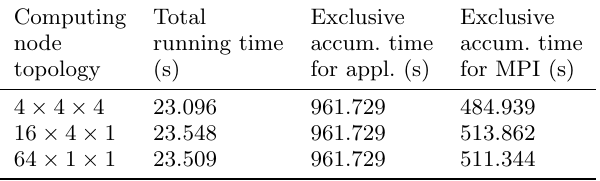
Table 1: Simulation results for three topologies Computing Total Exclusive Exclusive node running time accum. time accum. time topology for appl. (s)